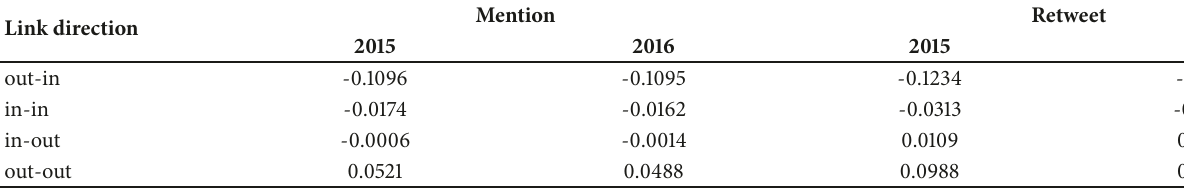
Table 4: Assortativities of the different aggregated networks.